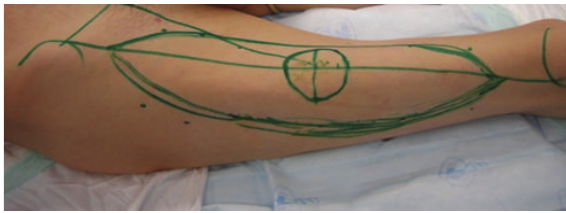
Figure 1: ALT flap design. Dimensions 12 cm × 40 cm.